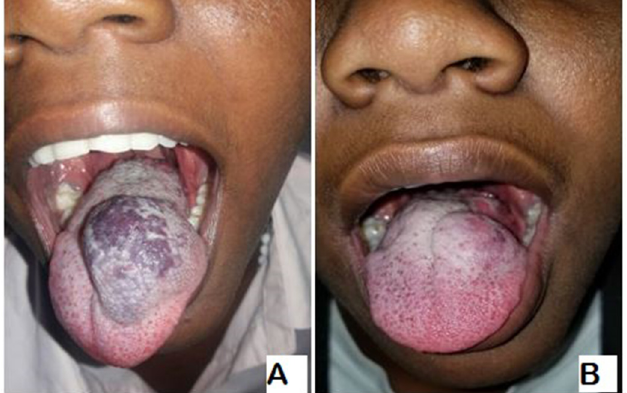
Fig. 4. (A) An infantile hemangioma of the tongue before treatment and (B) A signi fi cant reduction in size of the lesion after 5 cycles of intralesional bleomycin injections. Table II. Treatment modality according to age, sex and selected clinical features of the lesion.